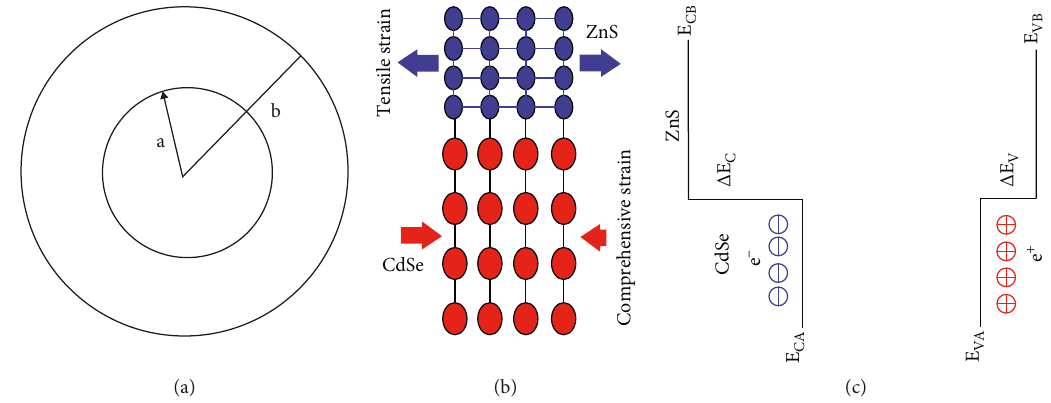
Figure 1: Schematic cross-sectional view of core/shell (a), interface strain (b), and band diagram (c) of pseudomorphic CdSe/ZnS heterostructure core/shell quantum